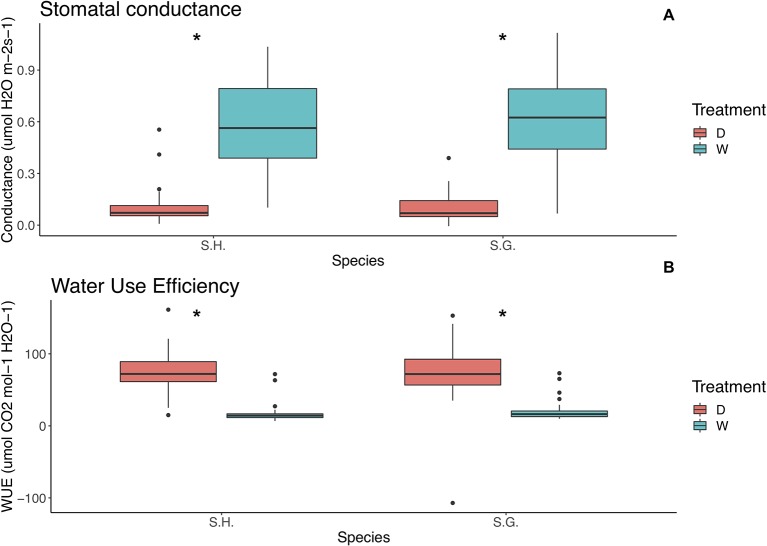
Relationship between (A) stomatal conductance (µmol H2O m‑2 s‑1) and species and (B) water use efficiency (µmol CO2 mol‑1H2O‑1) and species. Red boxes represent the dry treatment and green boxes represent the wet treatment. S.H., Schizanthus hookeri; S.G., Schizanthus grahamii; D, dry treatment; W, wet treatment.; WUE, water use efficiency. Significance level: *P < 0.01.